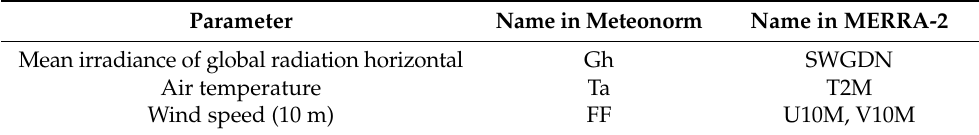
Table 3 is the list of mutual parameters and their corresponding names in Meteonorm and MERRA-2 datasets to be compared in this study. Table 3. Parameters to compare between Meteonorm and